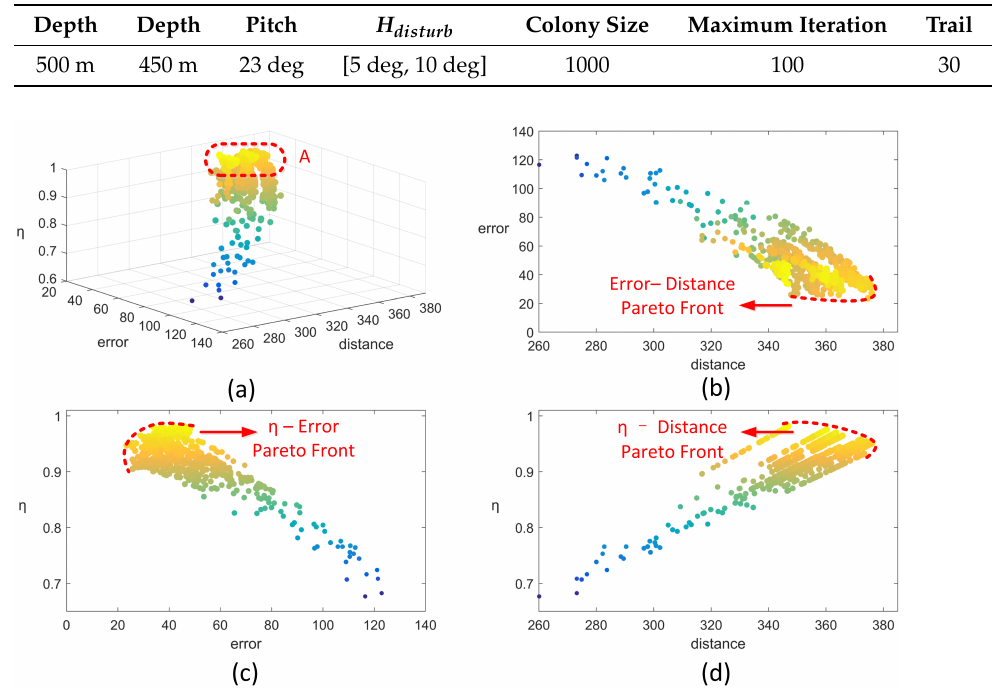
Figure 9. Pareto Front and the convergence process of algorithm: ( a ) 3D simulation diagram of the convergence process; ( b – d ) the projection of 3D simulation diagram on three